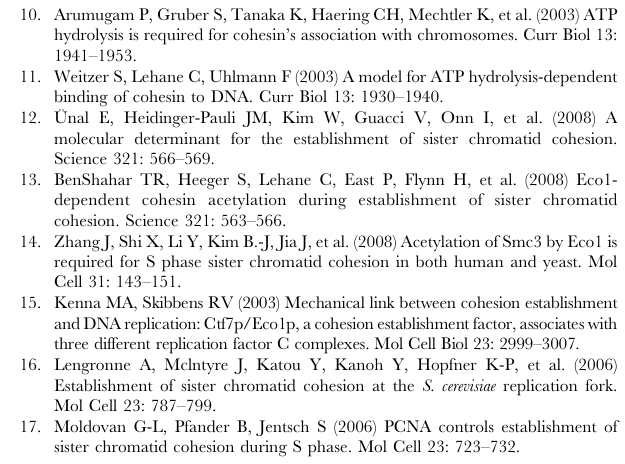
Figure S1 Upregulation of mitotis-specific genes in etg1 mutants. Real-time RT-PCR analysis of mitosis-specific genes PLEIADE (PLE) , KNOLLE (KN) , AURORA 2 (AUR2) , MYB3R4 , and CDKA;1 (as a control) in wild-type (Col-0; white bars) and etg1-1 (black bars) plants. Total RNA prepared from the first leaf of 8-day-old seedlings was amplified by RT-PCR. All values were normalized against the expression level of the ACTIN2 gene. Figure S2 Upregulation of cohesion establishment genes in E2Fa-DPa-overexpressing plants. Relative expression level of cohesion establishment genes ECO1, CHL1 , and CTF18 in wild- type (black) and E2Fa-DPa -overexpressing (white) plants. Data were imported from [25]. Figure S3 Conservation of the CTF18 protein in eukaryotes. Alignment of Arabidopsis CTF18 (ATCTF18) and its orthologous